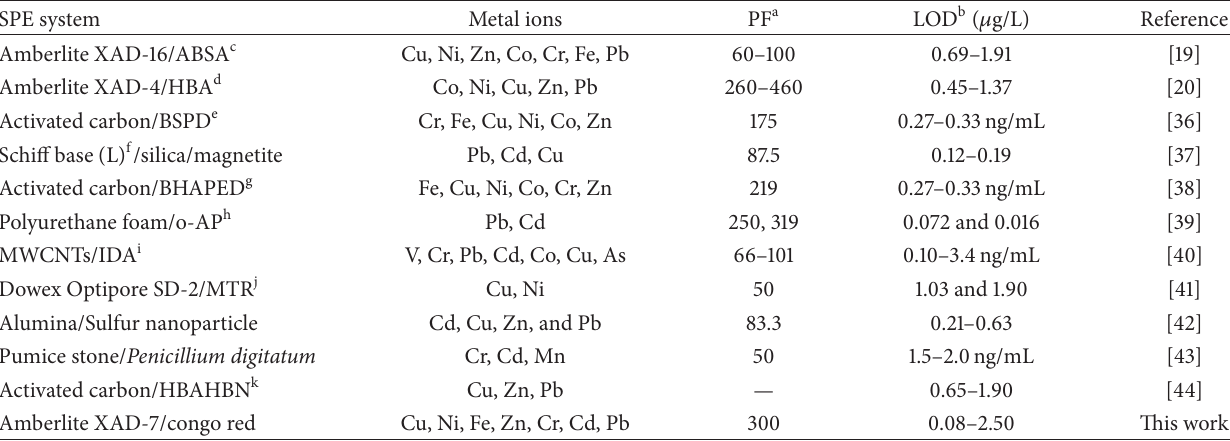
Table 6: Comparison of the proposed method with other SPE methods for determination of metal ions in fish samples by